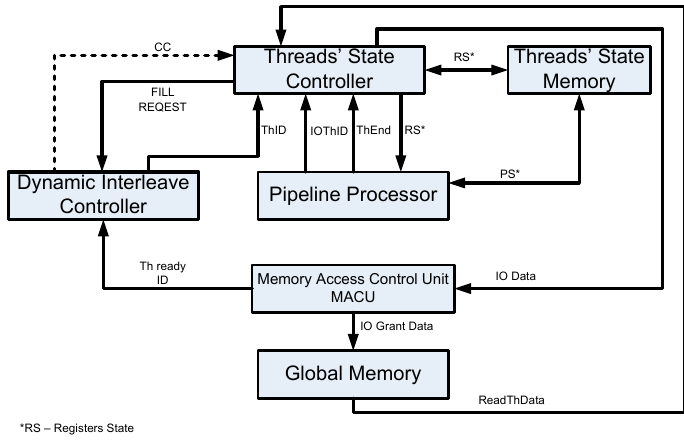
Figure 2. Architecture of a single-core SystemC model of the PRET architecture [3].